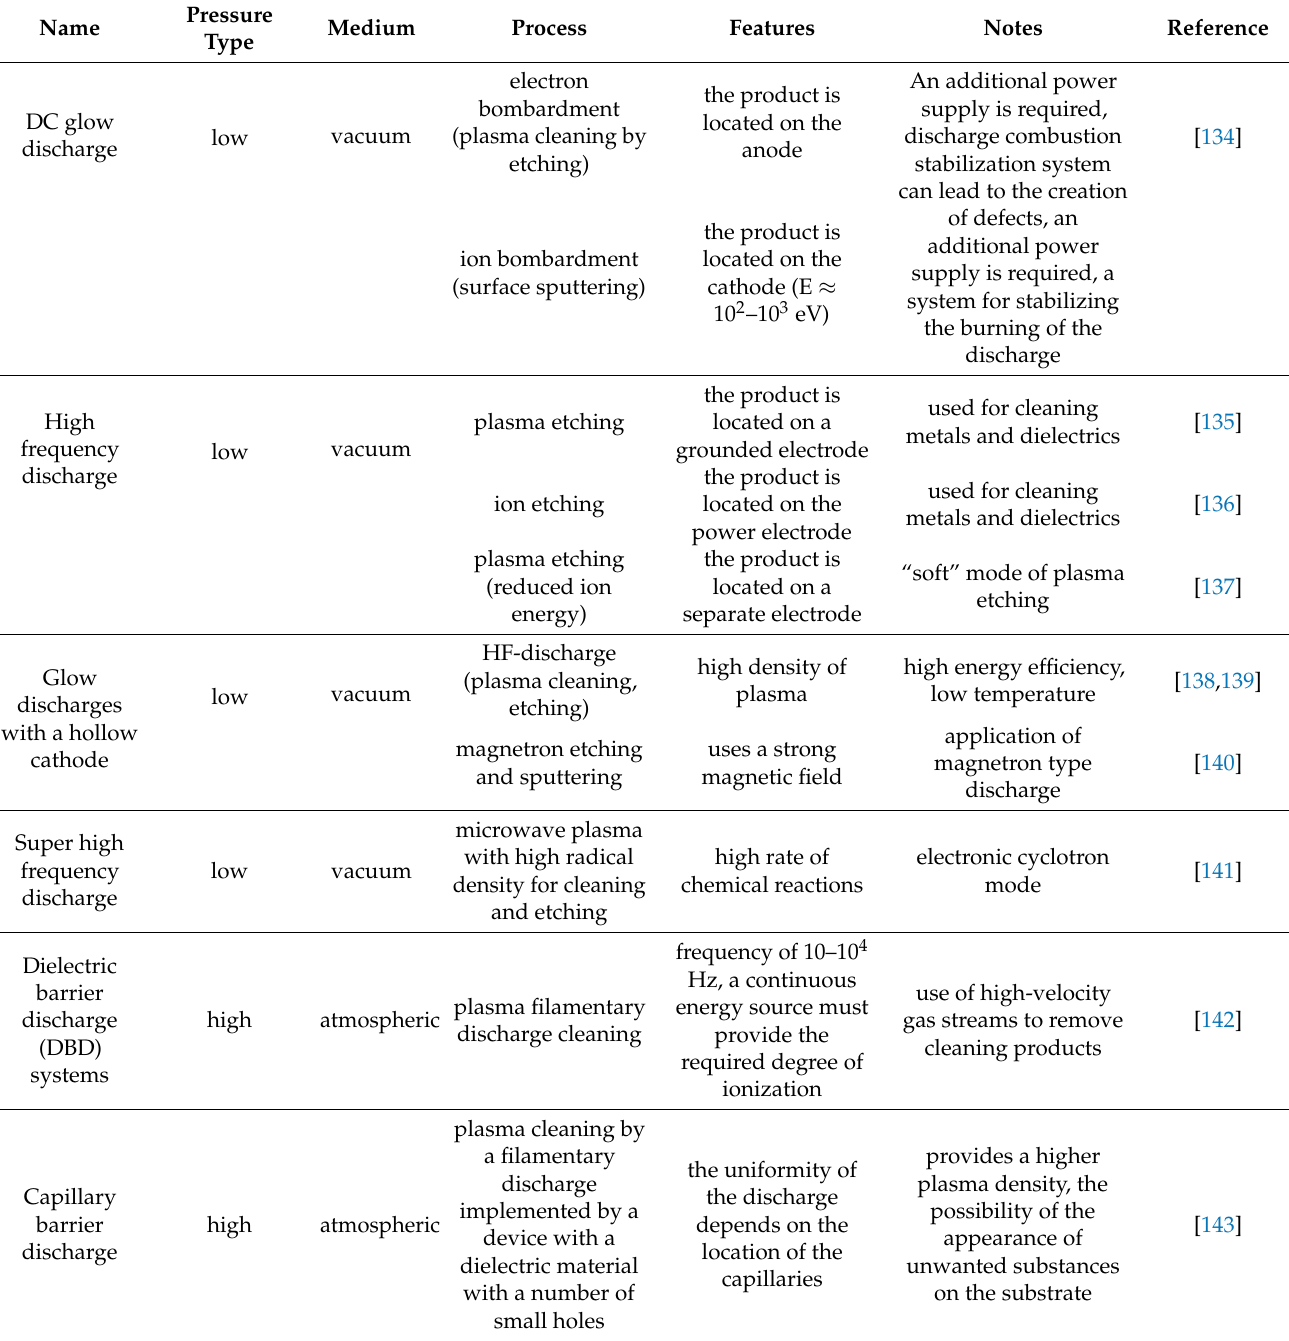
Table 5. Comparison of low- and high-pressure plasma